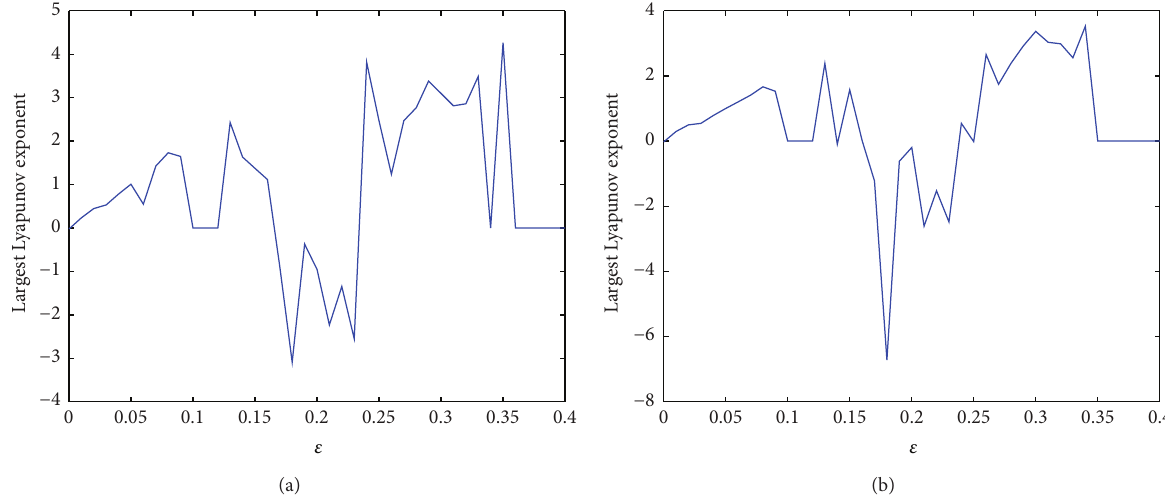
Figure 5: Largest Lyapunov exponent 𝜆 versus 𝜀 for system (83) with 𝑇 = 98 (a), 𝑇 = 100 (b), 𝜏 = 0.4 , and 𝜀 varying from 0 to 0.4.